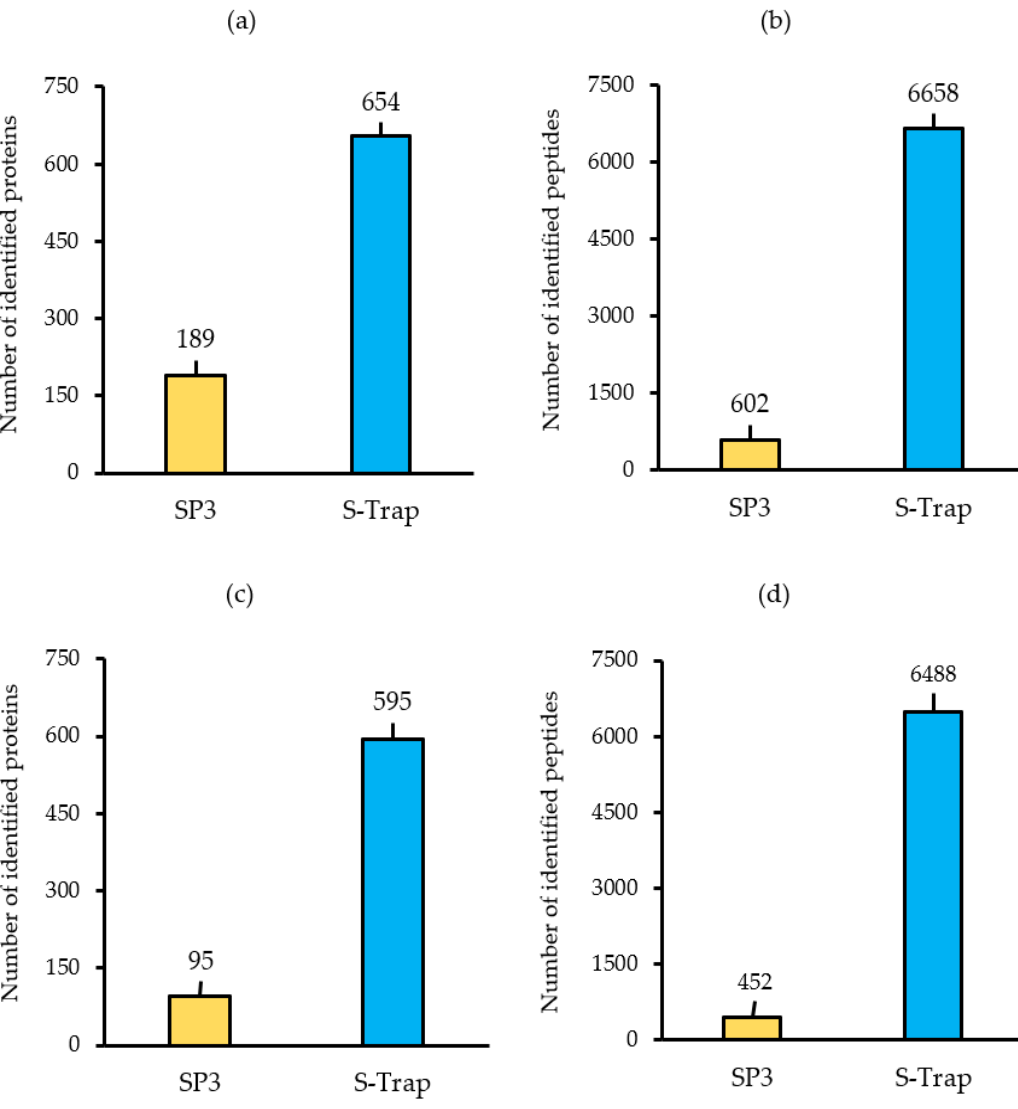
Figure 2. ( a ) Total number of proteins and ( b ) the total number of peptides identified in the database searches. Total proteins were filtered based on at least two unique peptides and include only those proteins detected in a minimum of three replicates ( c , d ). SP3: single-pot solid-phase-enhanced sample preparation, S-Trap: